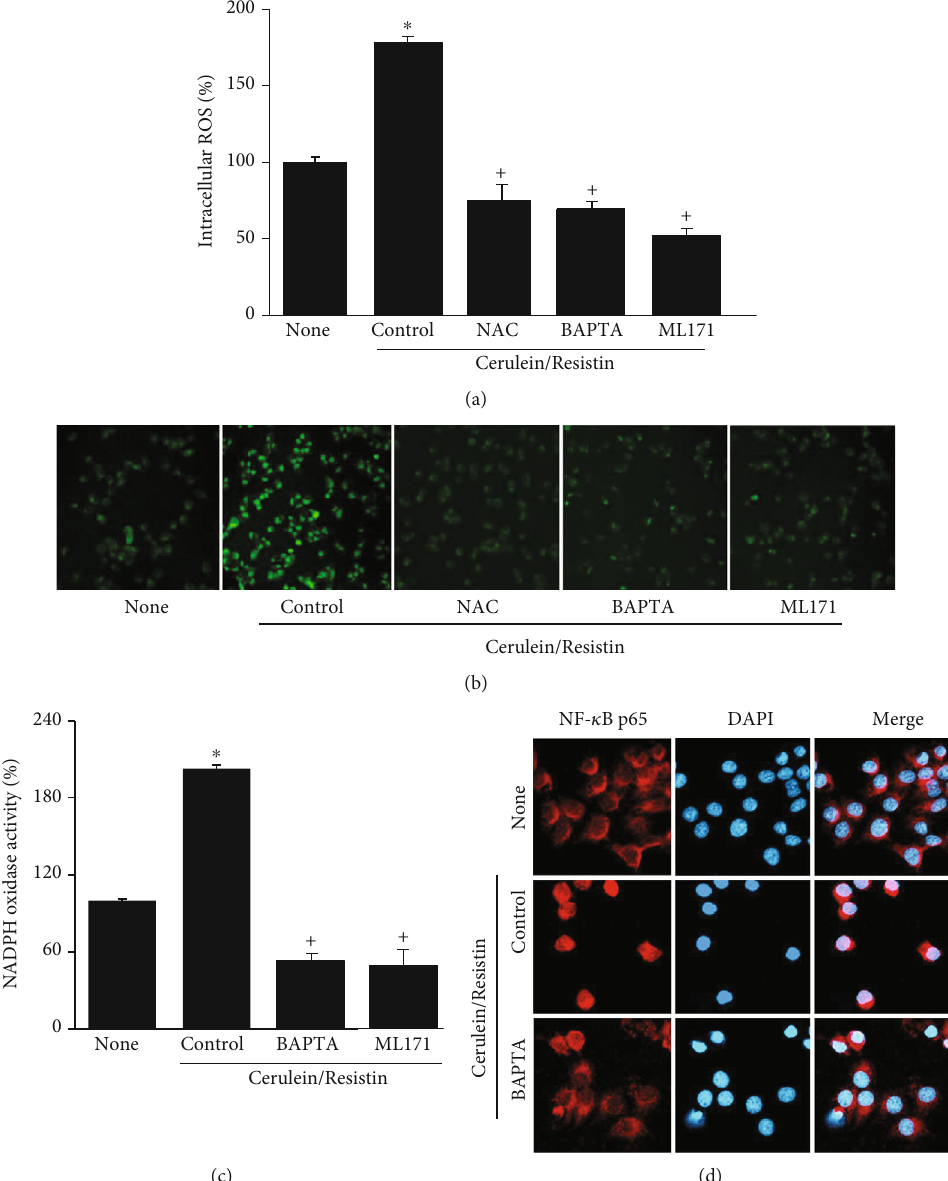
Figure 6: NAC, ML171, or BAPTA-AM inhibits cerulein/resistin-induced increases in ROS, NADPH oxidase activity, and nuclear translocation of NF- κ B p65 in AR42J cells. The cells were pretreated with NAC (1 mM) or ML171 (2 μ M) or BAPTA-AM (5 μ M) for 1 h and then stimulated with cerulein/resistin for 45 min (for ROS levels, ROS fl uorescence imaging, and NADPH oxidase activity (a – c)), and for 1h (for nuclear level of NF- κ B p65 by confocal images (d)). (a) Intracellular ROS levels were measured by dichloro fl uorescein diacetate (DCF-DA) fl uorescence. (b) Representative images of ROS-induced fl uorescence response of DCF-DA. (c) NADPH oxidase activity in the membrane fraction was measured by the lucigenin assay. Data are expressed as the mean ± S : E : of three di ff erent experiments. ROS level and NADPH oxidase activity in none (untreated cells) were set as 100%. ∗ p < 0 : 05 vs. none (untreated cells); + p < 0 : 05 vs. cerulein (cells treated with cerulein alone). (d) The immunoreactive NF- κ B p65 was visualized using a rhodamine-conjugated mouse anti-rabbit IgG antibody (red) with DAPI counterstaining (blue) of the same fi